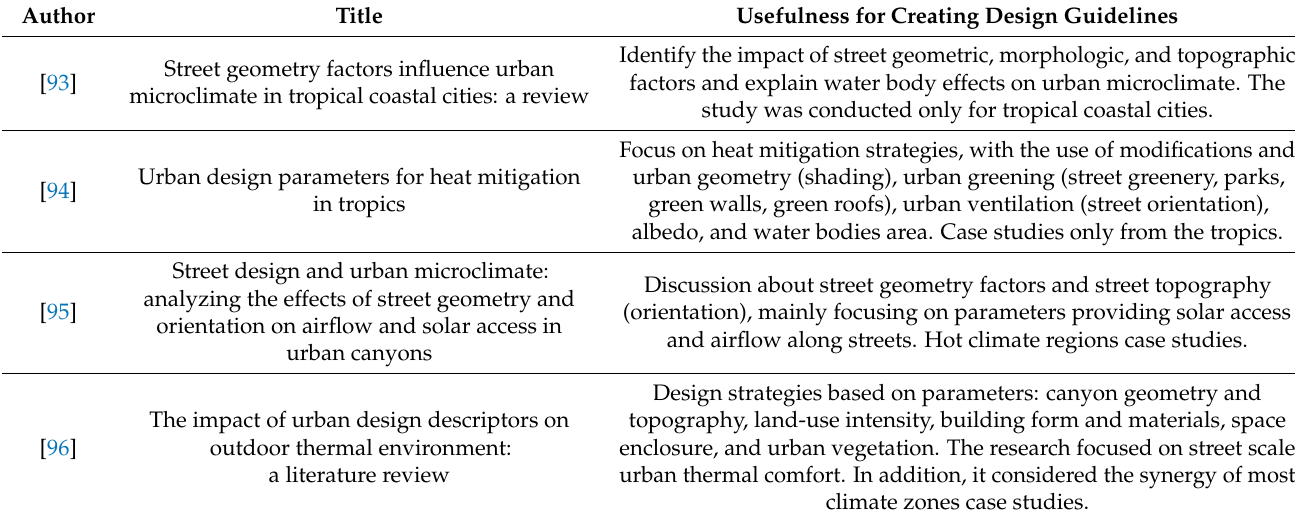
Table 2. Review articles published so far on the impact of urbanized environment (UE) parameters on UHI